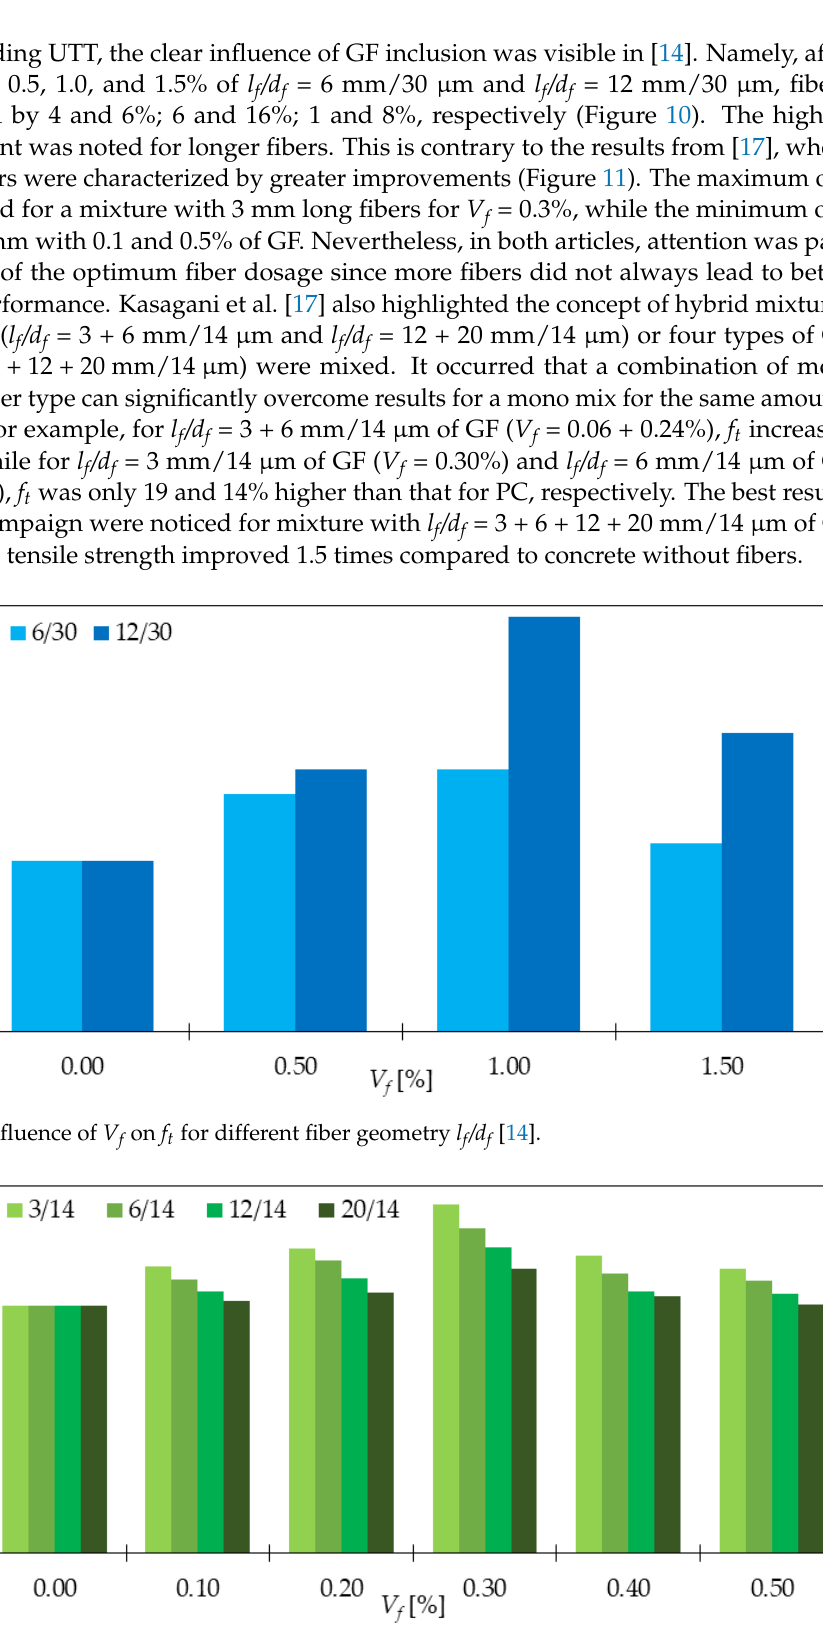
Figure 11. Influence of V f on f t for different fiber geometry l f /d f [17].